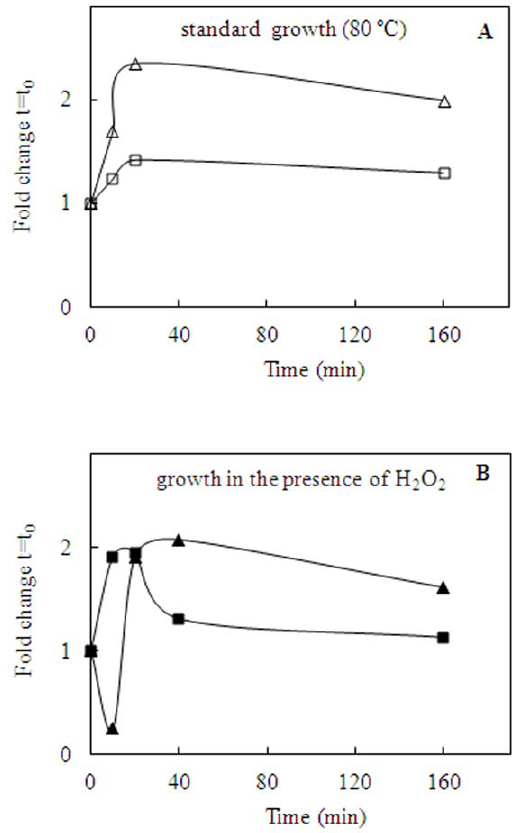
Figure 4. Transcriptional analysis under oxidative stress. ( A–B ) Comparisons of apeh Ss (squares) and apeh-3 Ss (triangles) fold changes of gene transcriptions under standard ( % ; n ) or oxidative ( & ; m ) conditions, normalized respect to the expression level at t=t 0 of 23S gene.